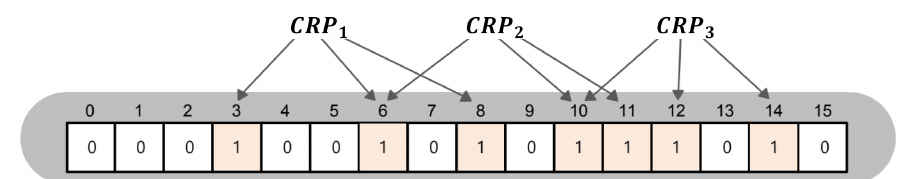
Figure 4. Programming procedure for a